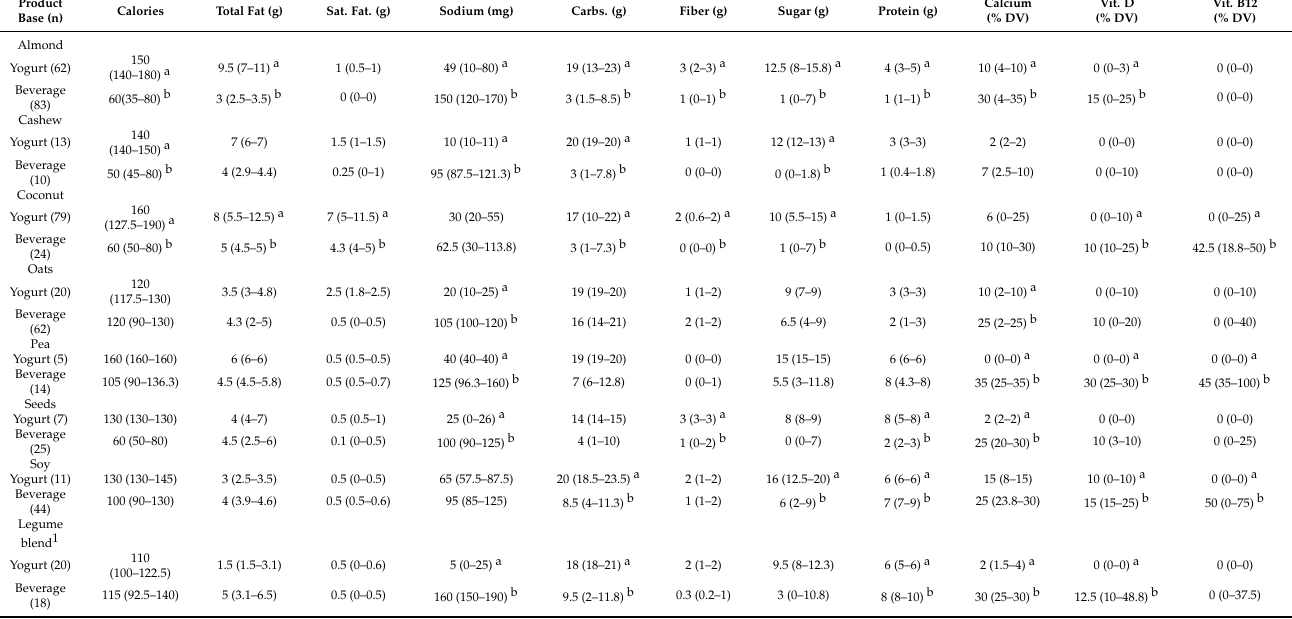
Table 6. Comparison of nutrient content of non-dairy yogurts and plant-based non-dairy beverages by base. For each yogurt base, different lowercase letters in the same column indicate significant differences between the plant-based beverages and the non-dairy yogurt alternatives. P < 0.05 is considered statistically